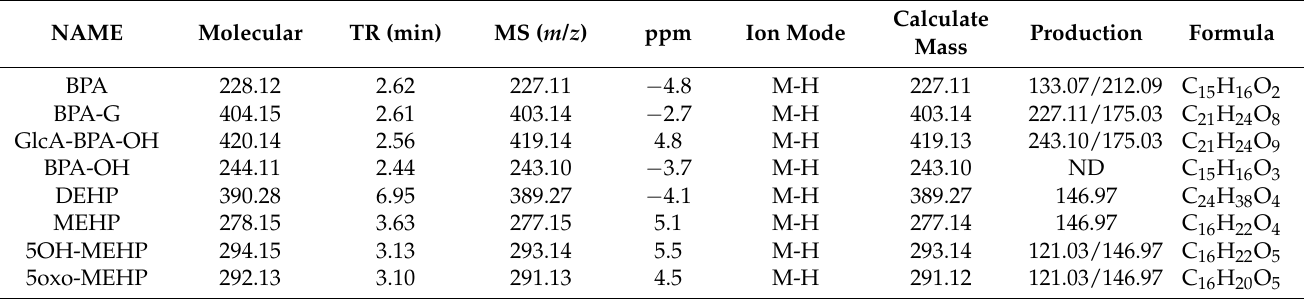
Table 4. UPLC-Q-TOF/MS analysis results of BPA, DEHP, and their